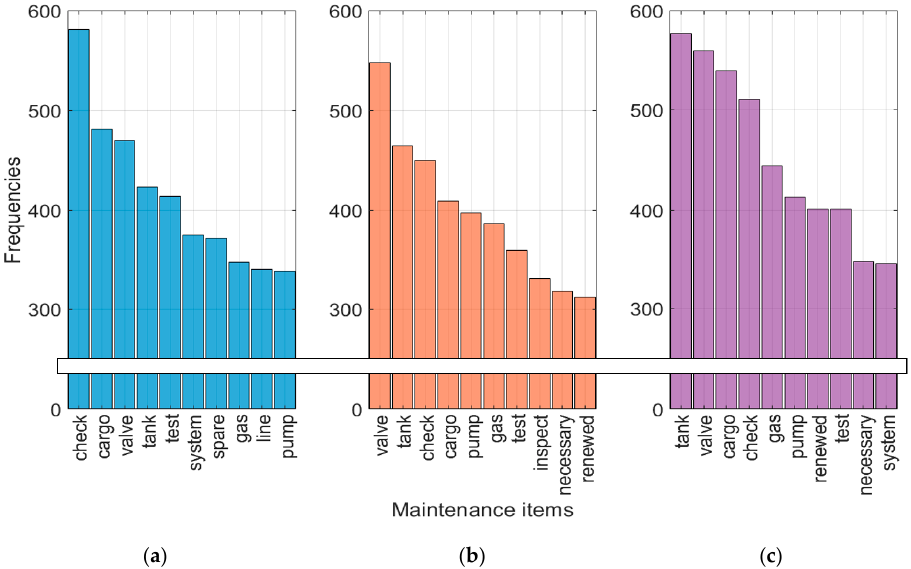
Figure 4. Histogram statistics to illustrate relative maintenance item frequencies: vessels aged ( a ) less than 10 years; ( b ) between 10 and 20 years; and ( c ) more than 20 years.